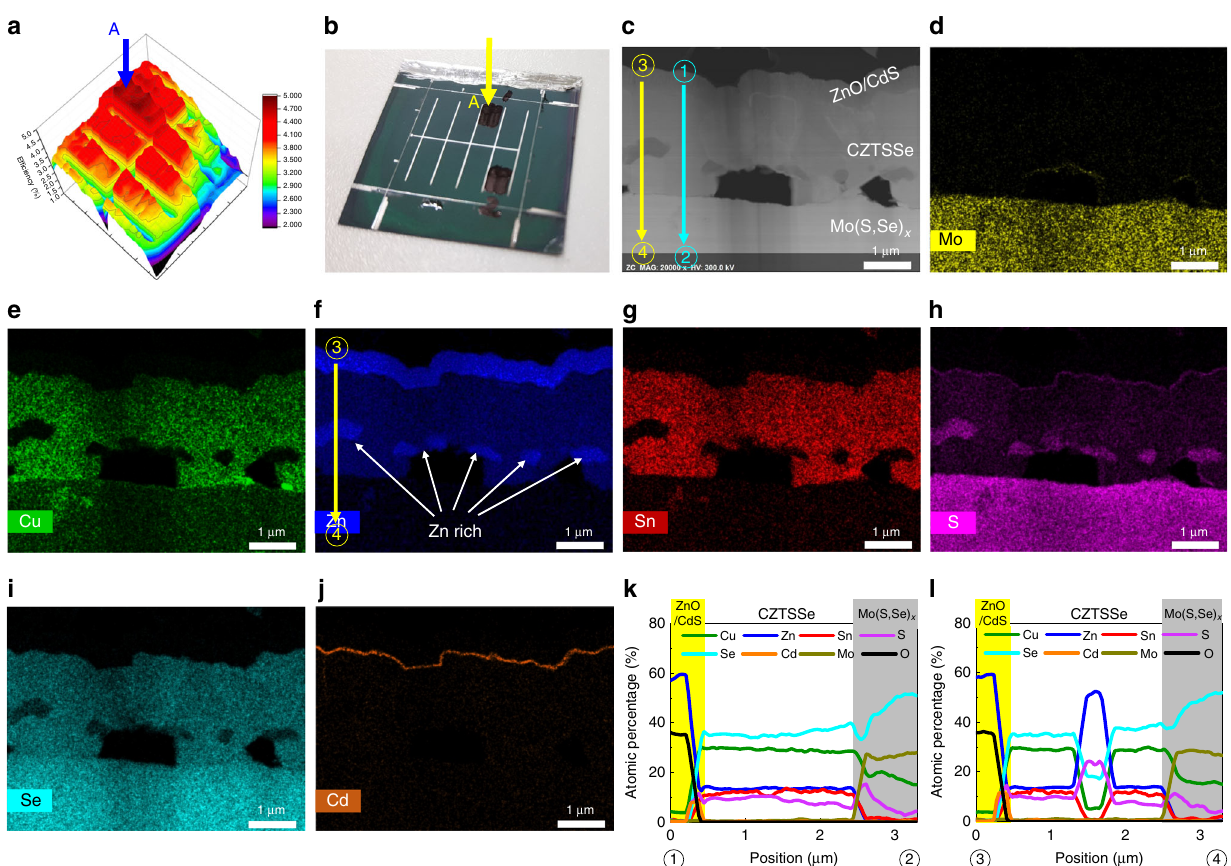
Fig. 5 STEM-EDS mapping images of point A of fl exible CZTSSe3-L. a Ef fi ciency mapping image using MIV measurements. b Real sample image. c Cross- sectional STEM image. EDS mapping images of the CZTSSe3-L absorber layer showing mappings of d Mo, e Cu, f Zn, g Sn, h S, i Se, and j Cd. The elemental variations across the vertical and lateral directions in STEM images ( c ) were measured using EDS line scans. k EDS line scan of ① → ② . l EDS line scan of ③ →